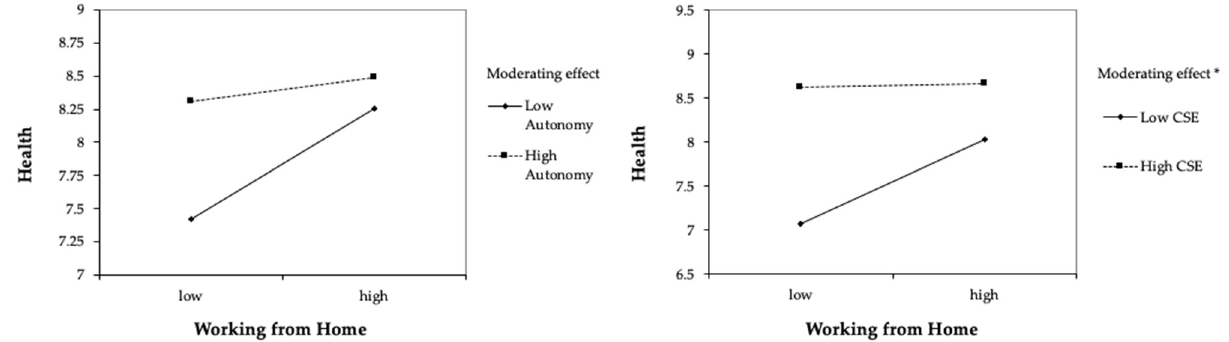
Figure 2. Plot of the interaction between working from home intensity and autonomy (2a), and working from home intensity and core self–evaluations (2b) on health. * p < 0.05.